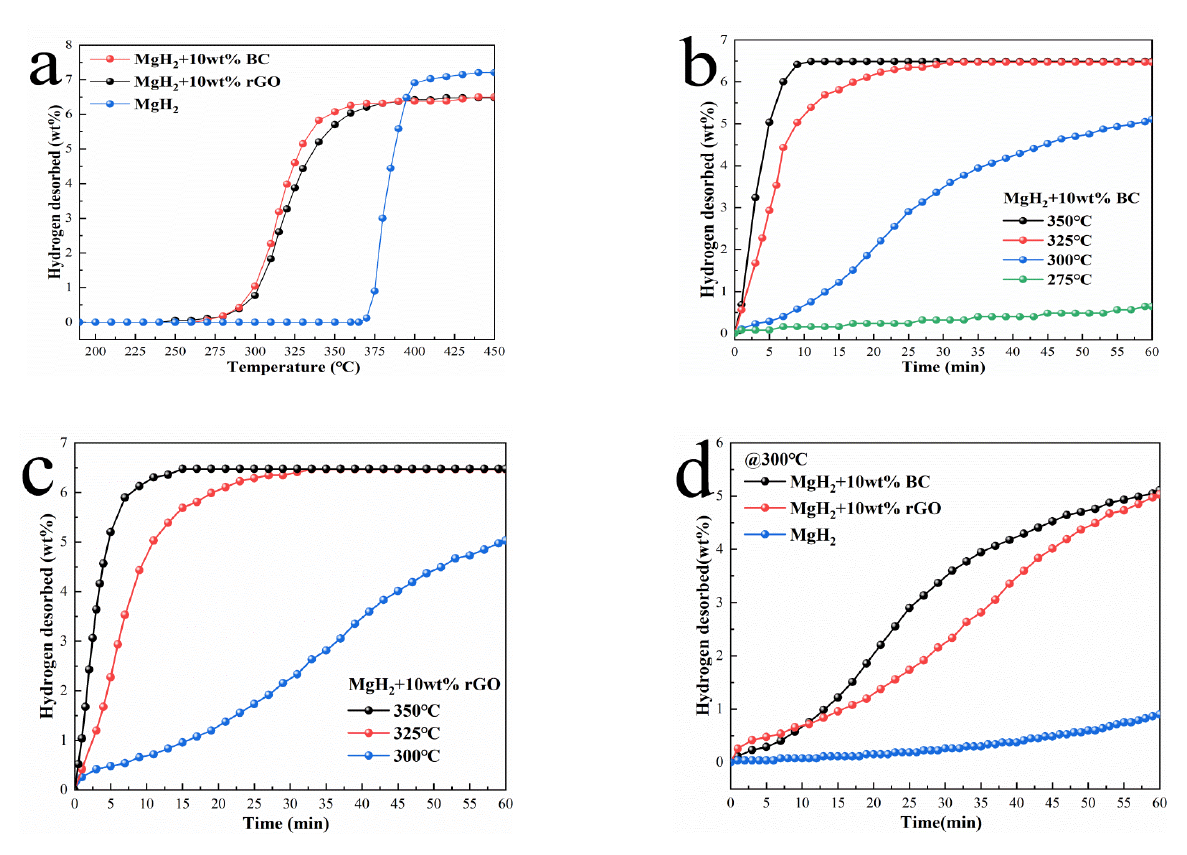
Figure 3. The rising temperature dehydrogenation curve of ( a ) MgH 2 + 10 wt% BC, MgH 2 + 10 wt% rGO and MgH 2 . Isothermal dehydrogenation curves of ( b ) MgH 2 + 10 wt% BC and ( c ) MgH 2 + 10 wt% rGO. Isothermal dehydrogenation curve prepared at 300 °C for ( d ) MgH 2 , MgH 2 + 10 wt% BC, MgH 2 + 10 wt% rGO.